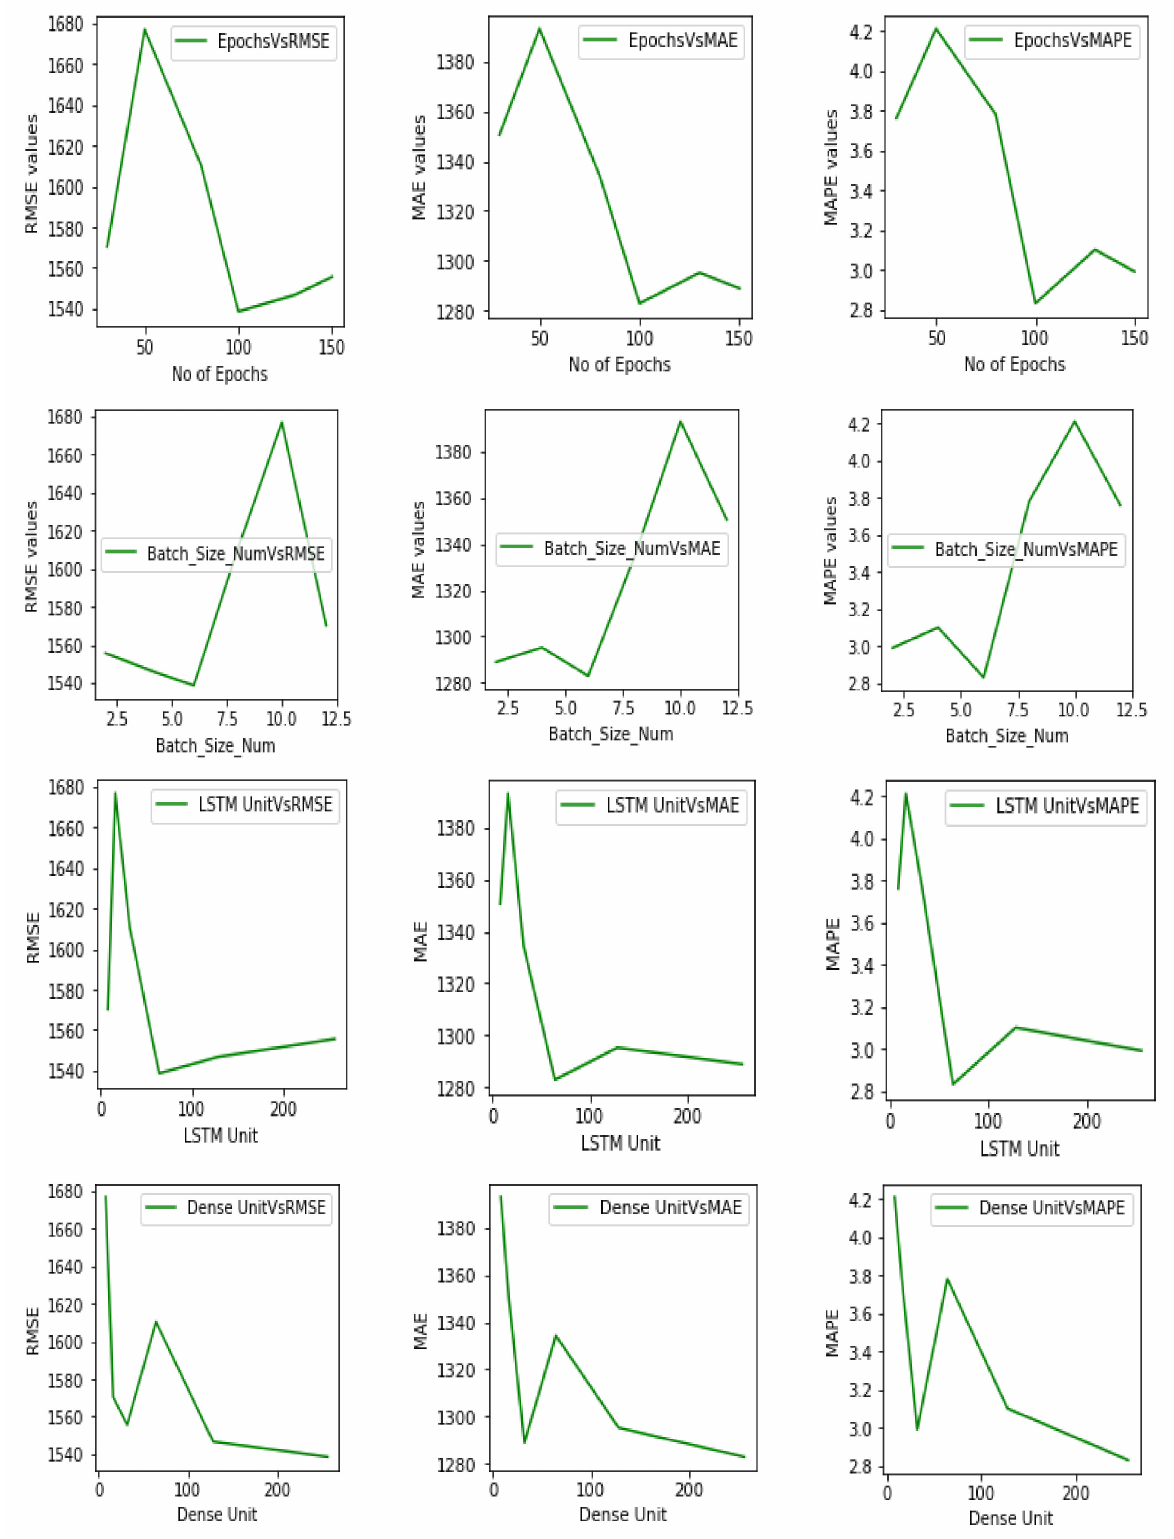
Figure 4. Sensitivity analysis of different parameters in case of United Kingdom arrivals in Hong